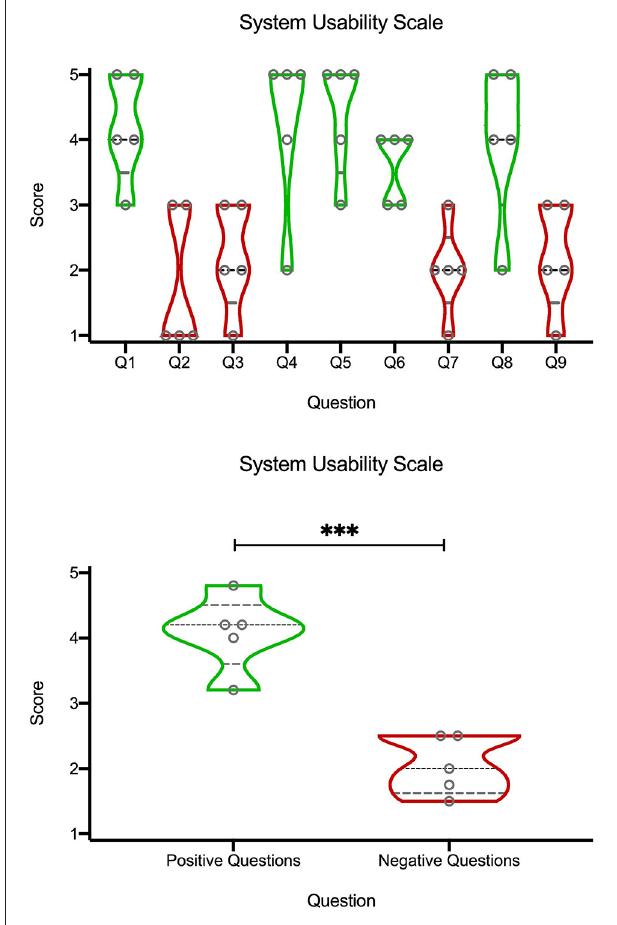
FIGURE 4 | Violin plots of quantification of the SUS questionnaire ( Table 1 ) on a Likert scale (1 corresponding to “strongly disagree,” and 5 to “strongly agree”). Black dashed line represents the median, the gray dashed lines represents the quartiles, and width of the violin corresponds to the number of points at a certain height. The top graph are the scores from individual questions. Bottom graph is an average from “positive” (green) or “negative” (red) questions. *** p < 0.01, unpaired